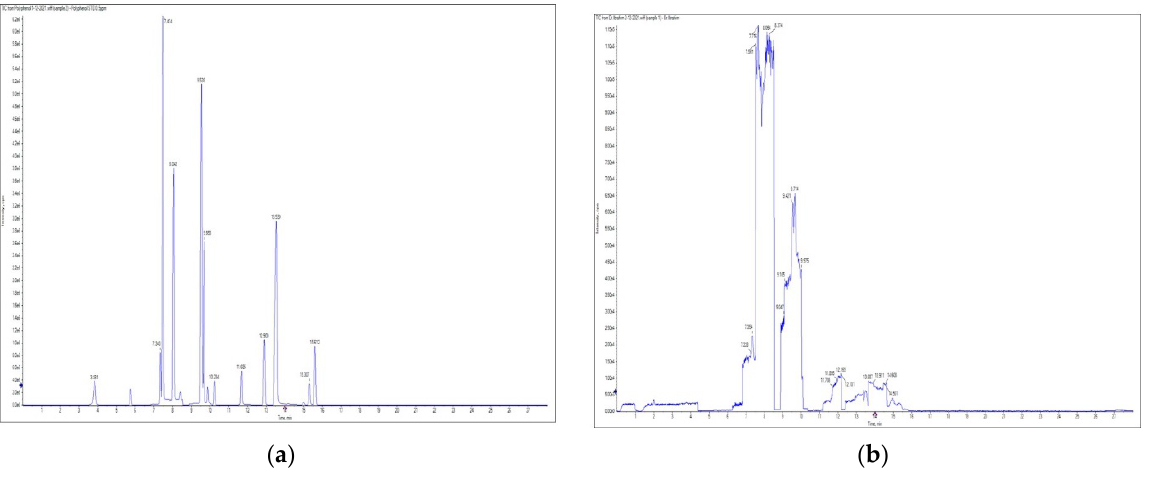
Figure 7. ( a ) represents LC MS/MS of standards and ( b ) represents LC MS/MS of synthesized MgAl-LDH intercalated Green tea oil (MgLDH-GT) after desorption using ethanol.